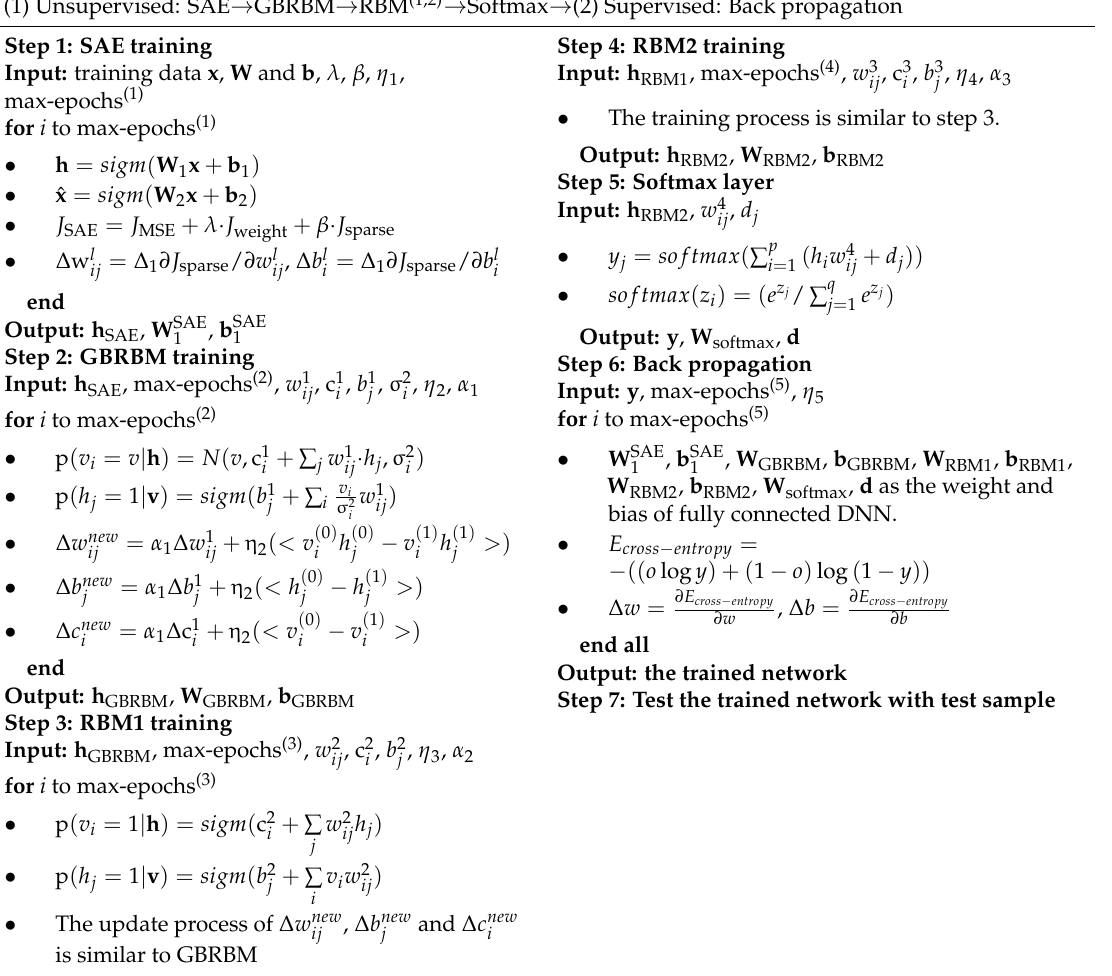
Table 1. Detailed process of proposed